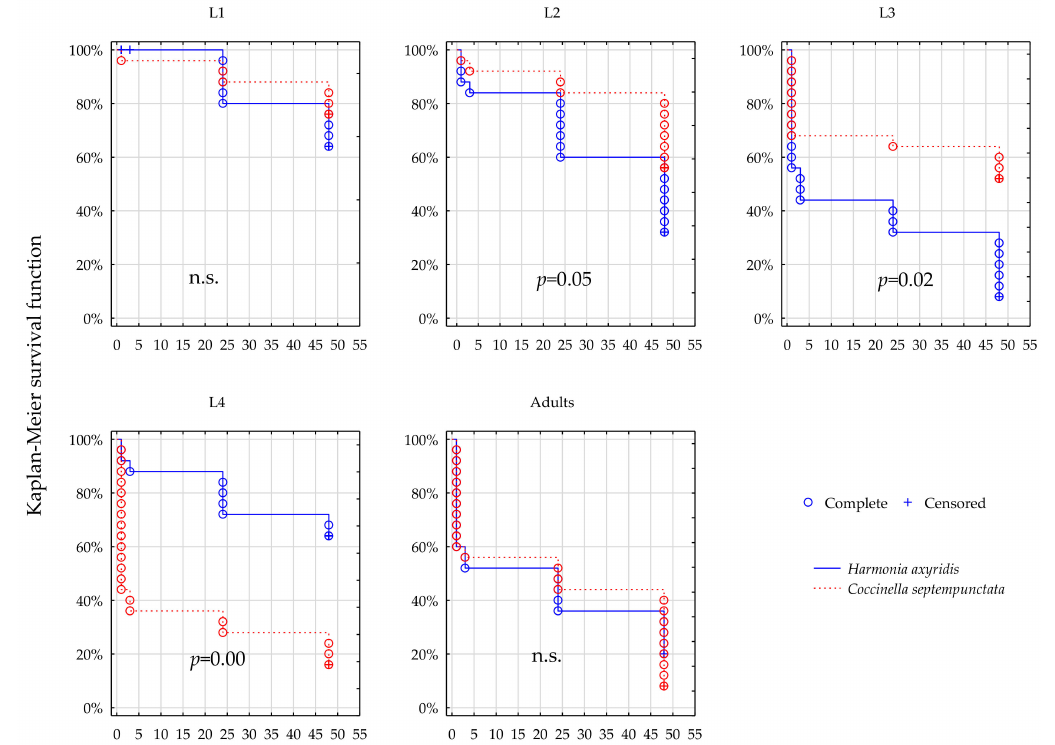
Figure 4. Survival dynamics of larvae and adults of the two predators after foraging on the prey treated with Calypso at 50% recommended field